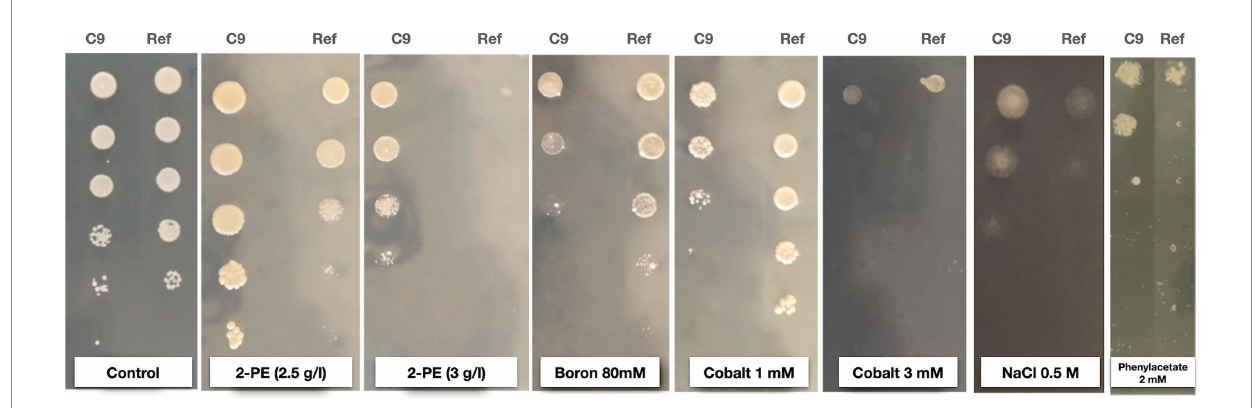
FIGURE 2 Survival rates of the final population of selection (56th passage), and the individual evolved strains C2, C3, C9, and C10, selected from the final population, in the presence of 3 g/L 2-phenylethanol stress. The survival rates are shown as fold of the reference strain’s survival